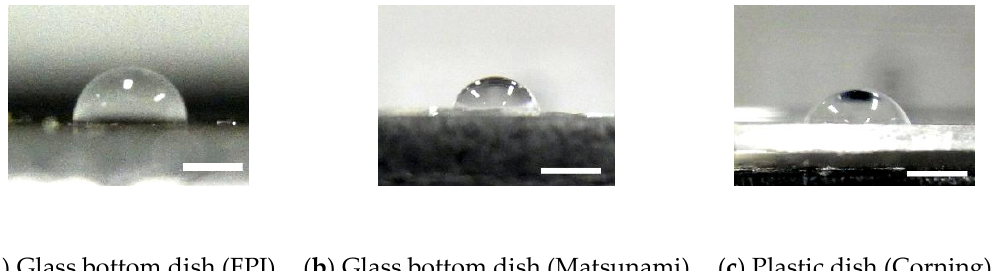
Figure 1. Typical images of droplets plated on ( a ) glass bottom dishes manufactured by Fine Plus International (FPI) and ( b ) Matsunami and ( c ) a plastic dish. Image contrast was enhanced for visibility. Bars correspond to 2 mm calibrated at the surface of the dish.